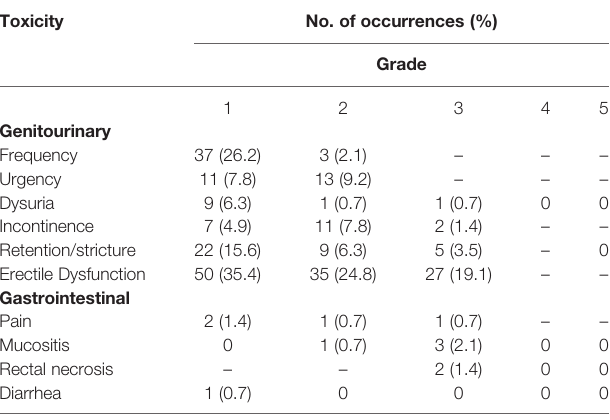
TABLE 3 | Late toxicity